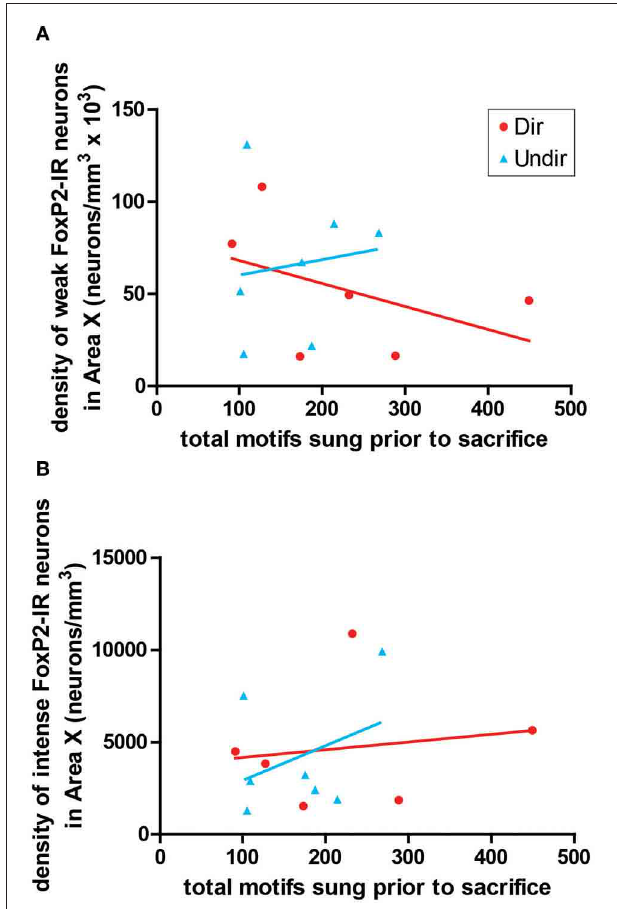
FIGURE 6 | Expression of FoxP2 did not correlate with level of singing. The density of weakly-stained (A) and intensely-stained (B) FoxP2-IR neurons did not co-vary with the number of bouts sung in the 2h prior to sacrifice in Dir (red circles) and Undir (blue triangles)